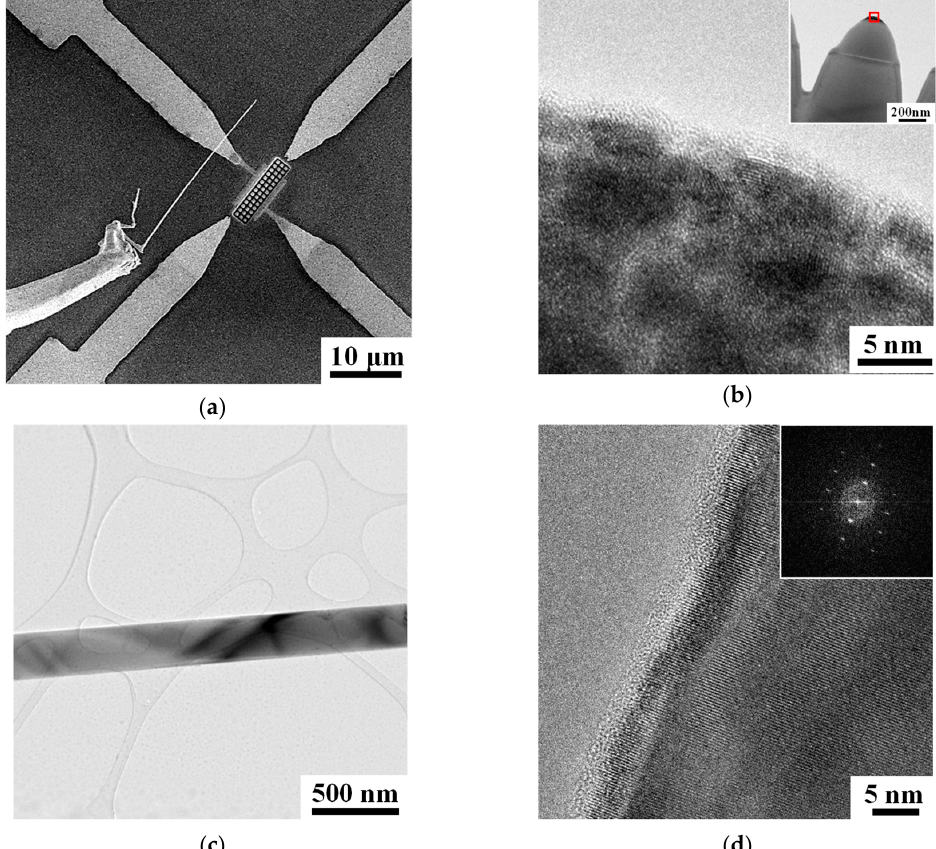
Figure 2. ( a ) A single nanowire is transferred to the top of nanoarray by a manipulator. ( b ) A high- resolution TEM image taken from the region marked in the inset of one hybrid nanoneedle, showing the dispersed Pt nanocrystallites in the amorphous matrix. ( c ) A bright field TEM image of a